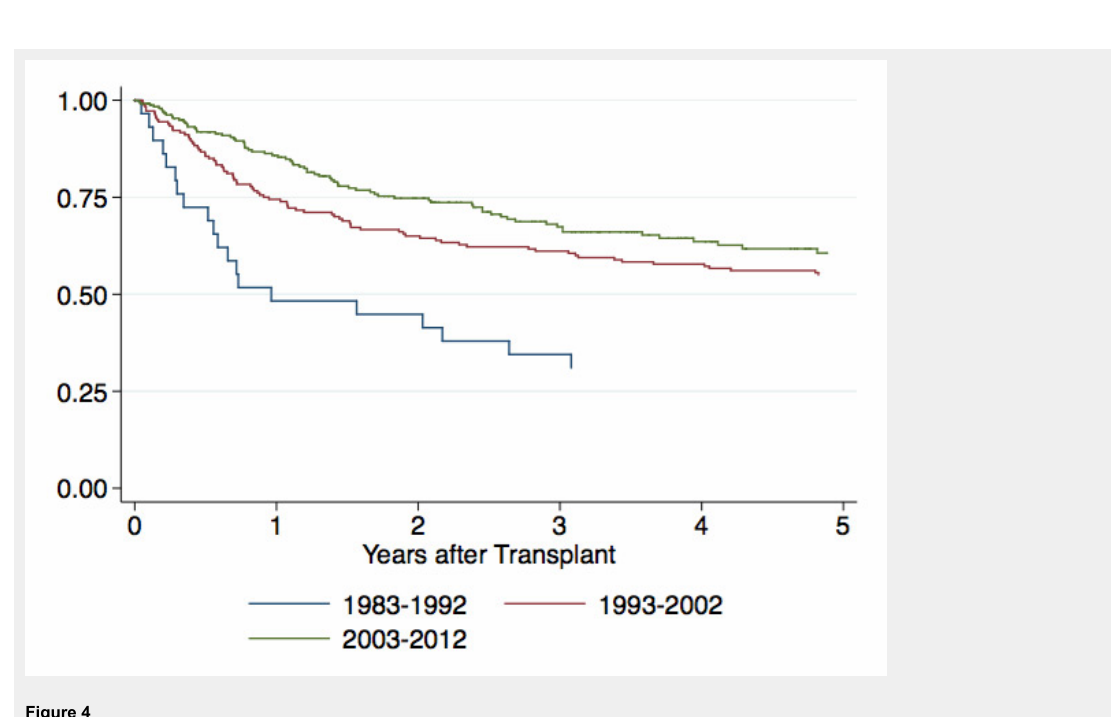
Figure 4 Overall survival after autologous haematopoietic stem cell transplantation